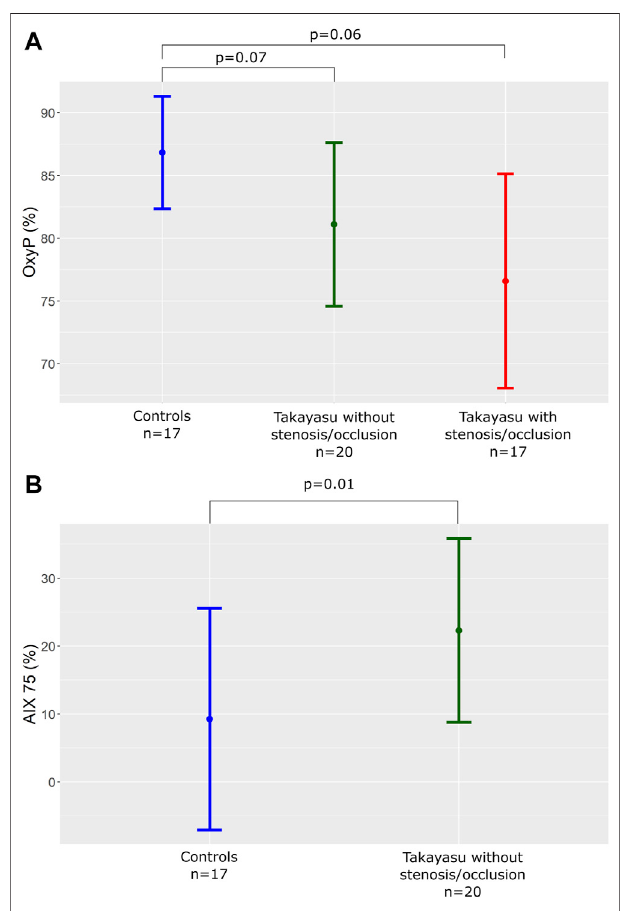
FIGURE 4 | (A) OxyP (%) in controls and patients with or without signi fi cant stenosis or occlusion in the arm arteries. OxyP, peak oxygen saturation. (B) AIx75(%)incontrolsandpatientswithoutsigni fi cantstenosisor occlusion in the arm arteries. AIx75, Augmentation Index adjusted for heart rate 75.